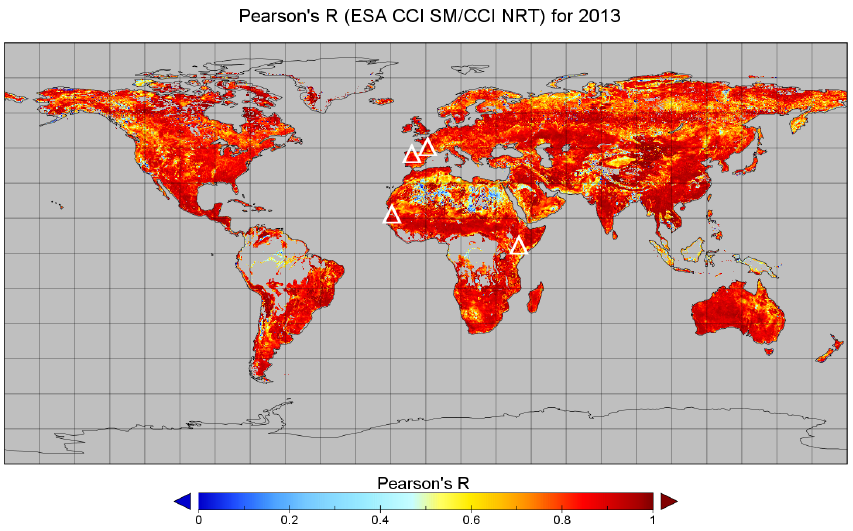
Figure 5. Global correlation (Pearson’s R ) for ESA CCI SM and CCI NRT for 2013 (no negative correlations were observed). The white triangles illustrate the location of the in situ stations/networks.